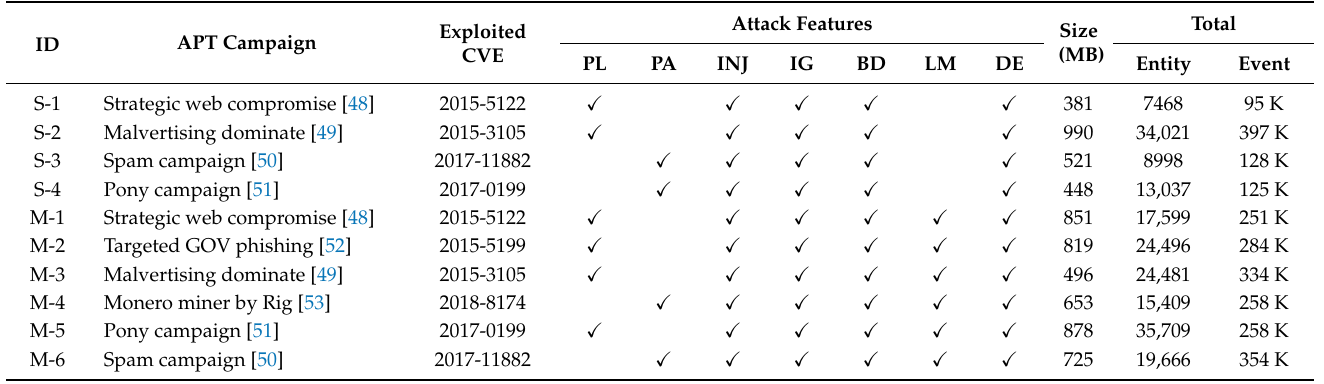
Table 2. Overview of implemented APT